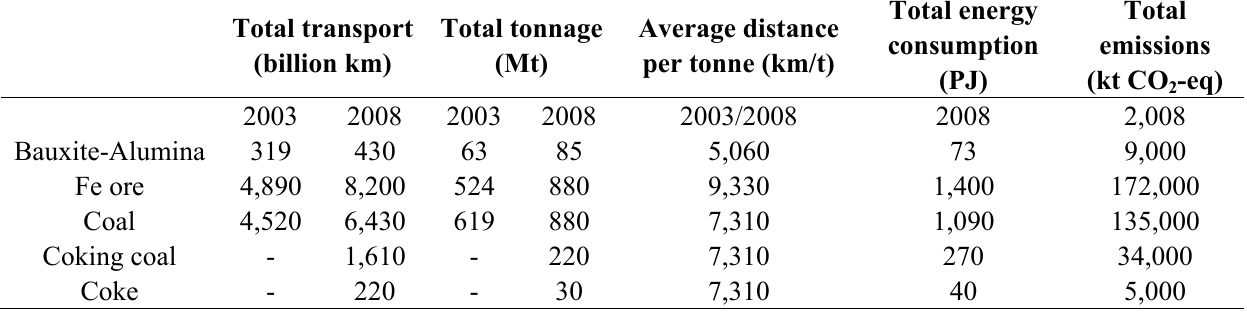
Table 1. Global maritime transport figures for bulk minerals in 2003 (based on [14]) and extrapolated to 2008.